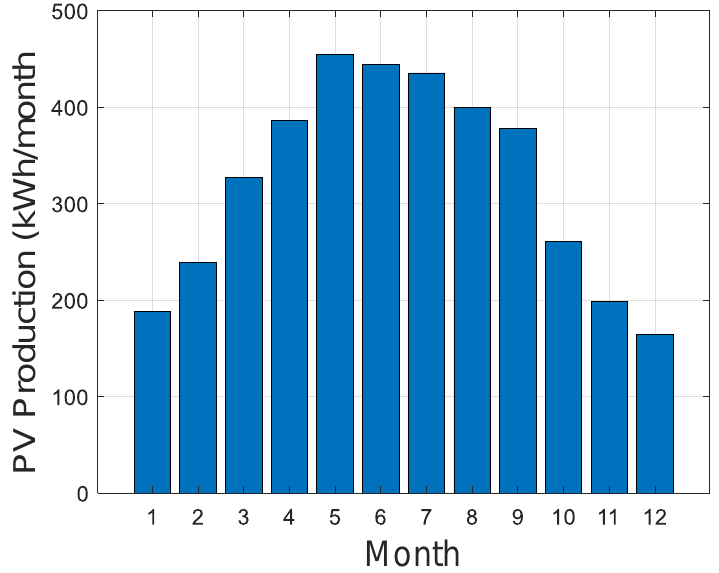
Figure 6. PV monthly production.